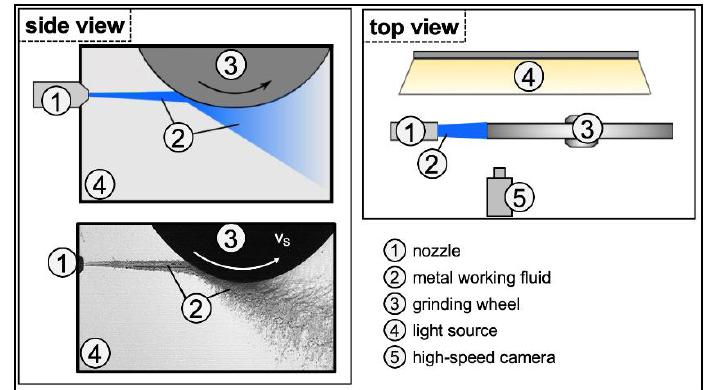
Figure 3. Experimental setup for high-speed records.